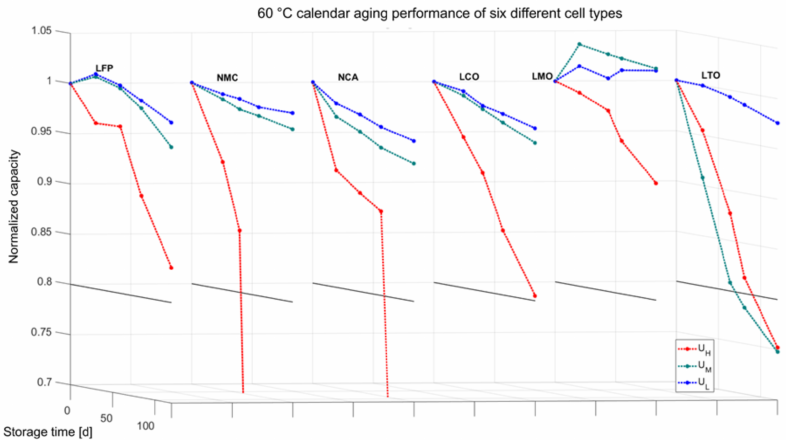
Figure 5. Normalized capacity decrease of six chemistries at 60 ◦ C storage over 120 days at three storage voltages (U L -voltage low, U M -voltage mid, U H -voltage high), each plotted point displays the average capacity of all individual cells at that same